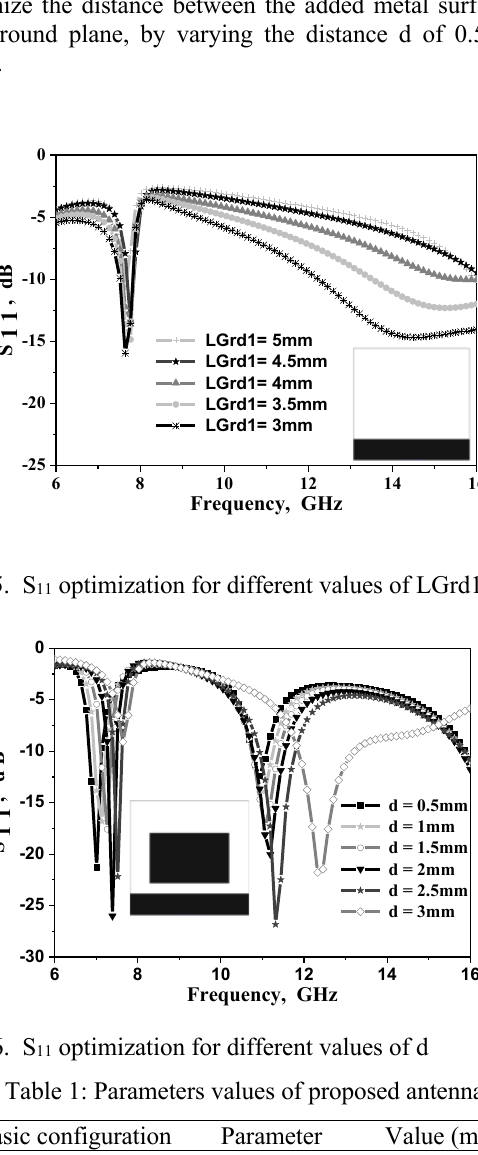
Fig. 4. The simulated S 11 curves for the antennas shown in Fig. 3